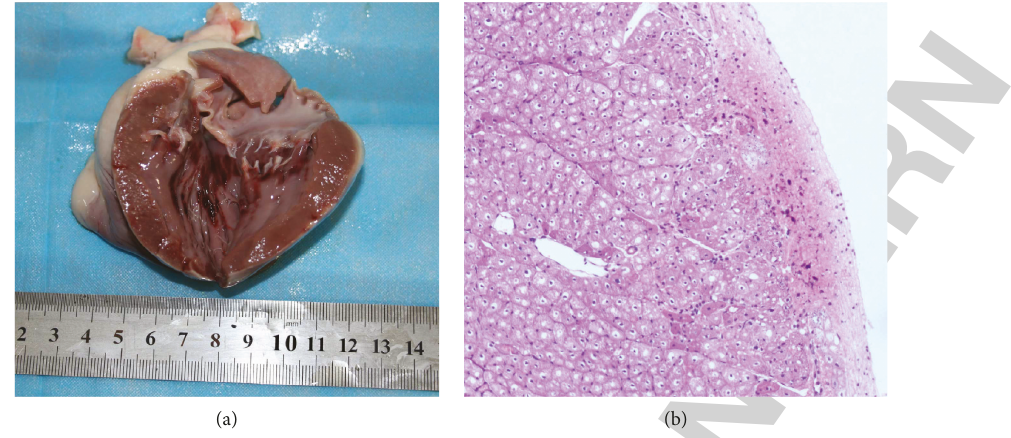
Figure 8: Subendocardial hemorrhage in gross and microscopic observation. (a) Subendocardial hemorrhage in gross observation in group I. (b) Subendocardial hemorrhage under microscopic observation in group I (HE × 100). Table 1: The AIS distribution of the injuries of the